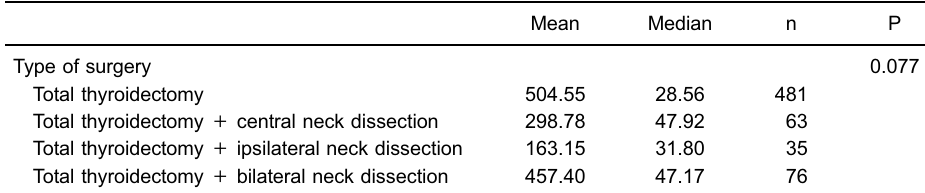
Table 3. Summary of postoperative stimulated thyroglobulin (ps-Tg) (ng/mL) levels by type of surgery and neck dissection in patients with differentiated thyroid